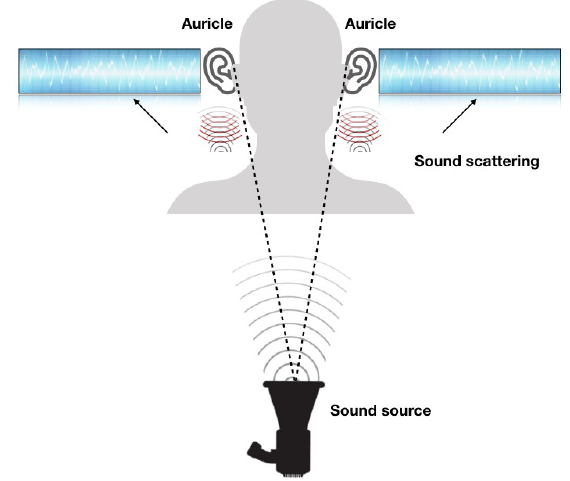
Figure 1: Schematic diagram of acoustic